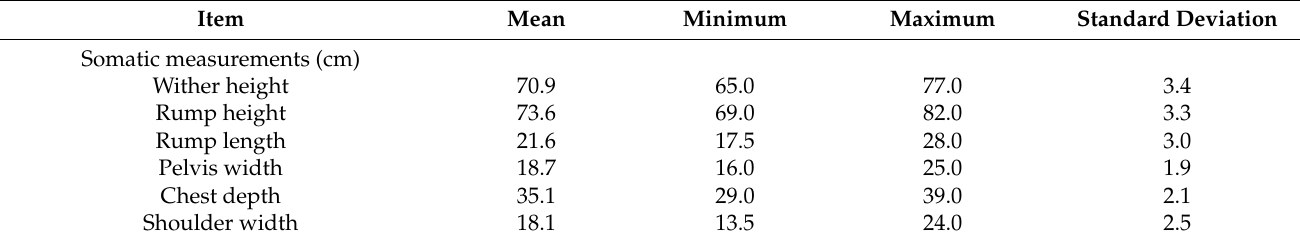
Table 1. Somatic measurements; body weight (BW); lumbar and sternal body condition scores (BCSl and BSs, respectively); hot carcass weight (HCW); empty body weight (EBW); lumbar, sternal, and perirenal fat thickness depth measured by ultrasound (FTUSl, FTUSs, and FTUSpr, respectively); lumbar and sternal fat thickness depth measured by digital caliper (FTDCl and FTDCs, respectively); and fat depot